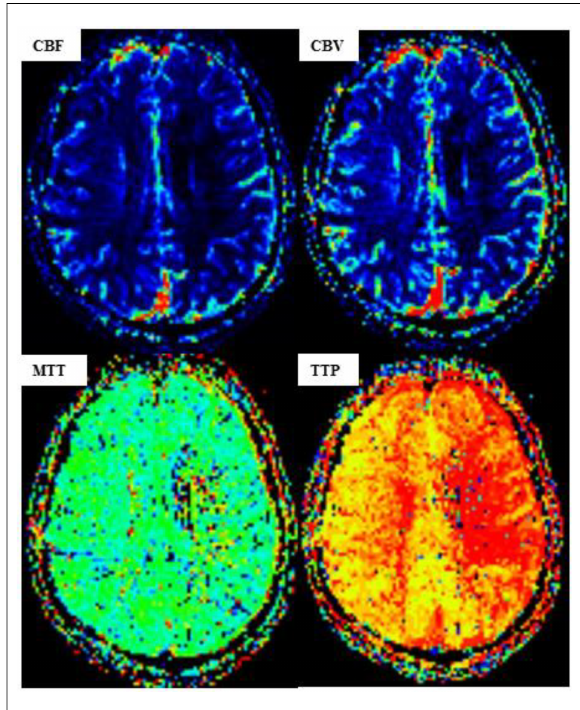
FIGURE 5 MR perfusion-weighted imaging (PWI) after carotid artery stent implantation (CAS). [PWI showing a lower cerebral blood volume (CBV) and cerebral blood fl ow (CBF) in the left hemisphere than those in the right hemisphere, while the time to peak (TTP) and mean transit time (MTT) are signi fi cantly higher.]